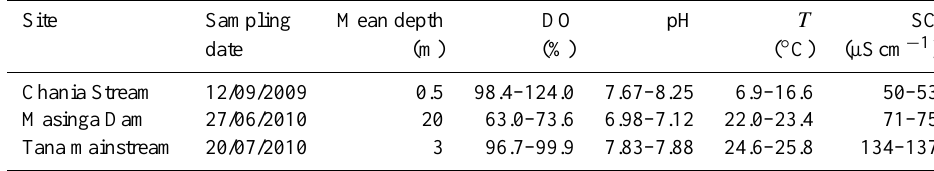
Table 1. Summary of the ranges in physico-chemical parameters for diurnal sampling sites.